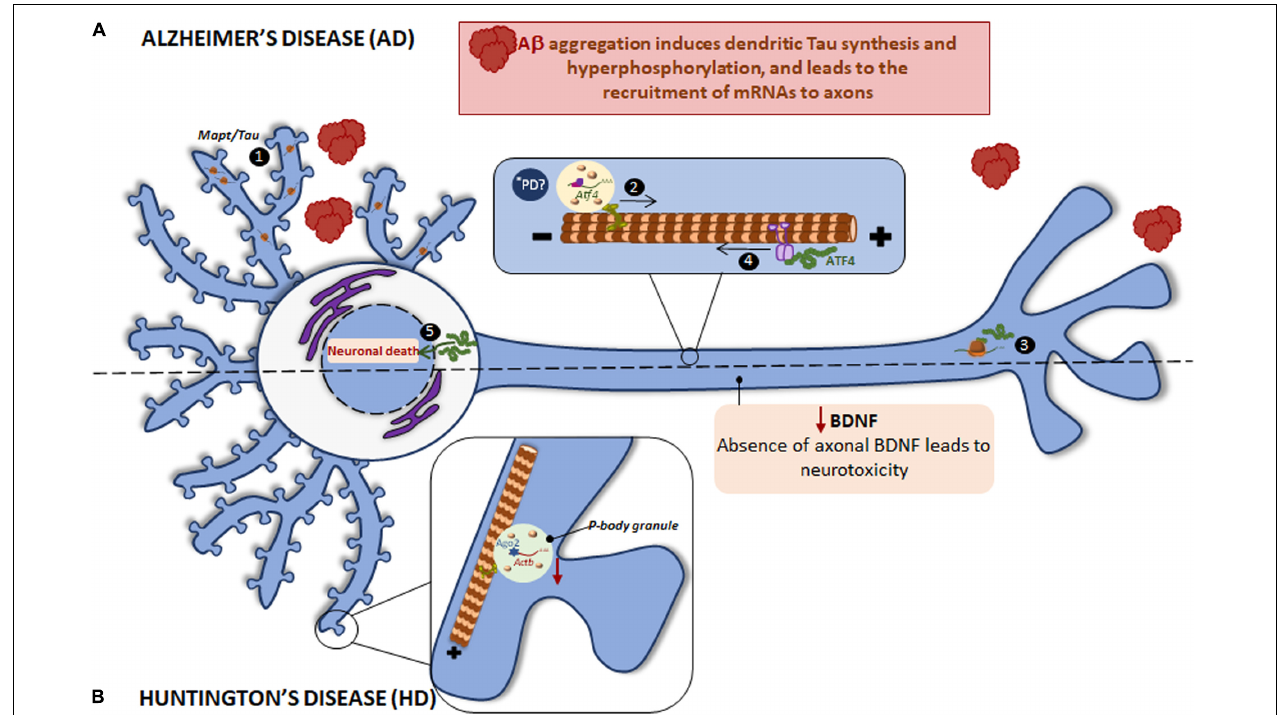
FIGURE 4 | Local translation defects in AD and HD. (A) The two main hallmarks in AD brains are the accumulation of intracellular hyperphosphorylated Tau and extracellular A β plaques. A β induces the incorrect localization of Mapt mRNA to dendrites with the consequent, local synthesis of Tau and its hyperphosphorylation (1). A β also induces the recruitment of certain mRNAs to axons, among them Atf4 is found (2). Once ATF4 is axonally synthesized (3), it is retrogradely transported to cell body (4) where enhances death transcriptional programs (5). * PD ATF4 is also a component of UPR. The UPR is altered in PD and therefore the local ATF4 could be involved in PD progression. (B) HD is caused by a mutant CAG expansion in HTT gene. HTT KO leads to reduced levels of Actb mRNA, Ago2 protein, and p-bodies in dendrites. Mutant HTT impairs BDNF transport to axons resulting in neurotoxicity and probably affects to local protein synthesis since BDNF regulate this process in subneuronal